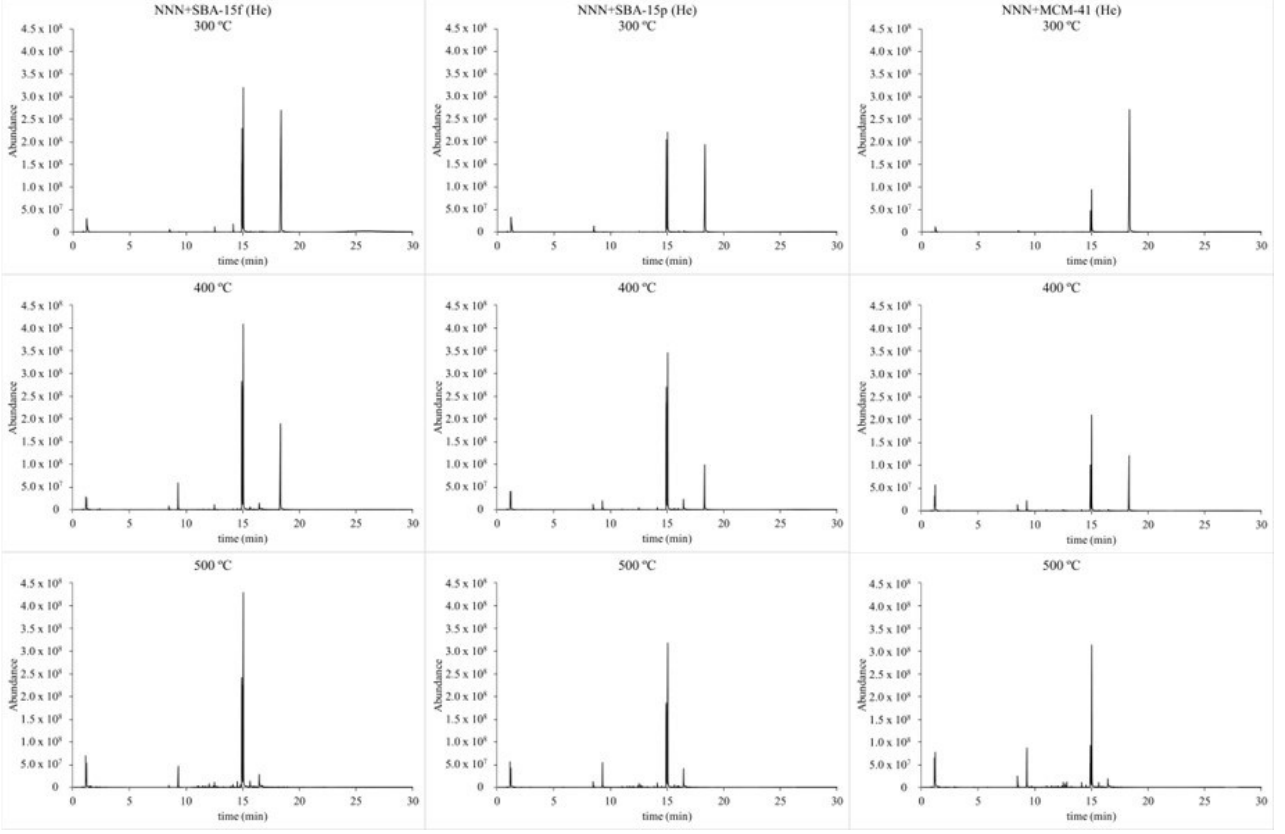
Figure 11. Chromatograms of the pyrolysis of NNN with SBA-15f ( left ), SBA-15p ( center ) and MCM-41 ( right ) at different temperatures under the He atmosphere.